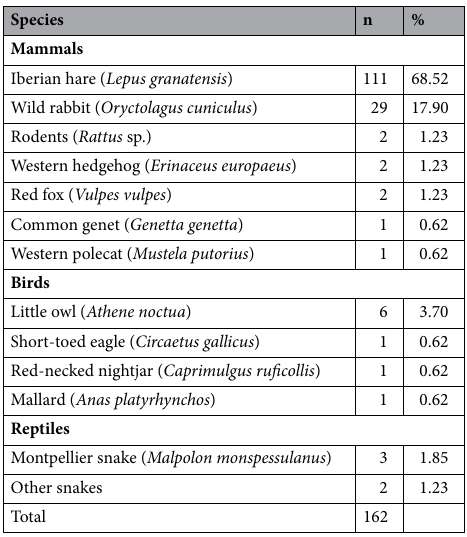
Table 3. Species detected during sampling for animal–vehicle accidents in the study area (March–July